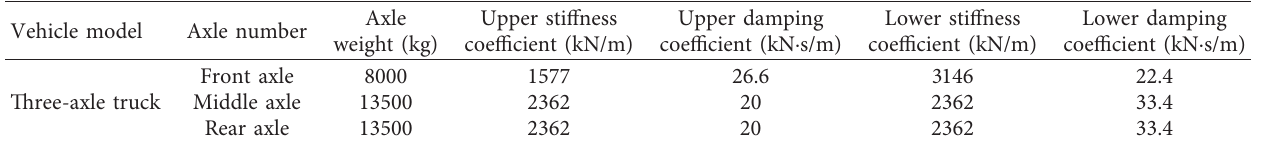
Figure 9: Information of bridge model and dynamic test (unit: Table 3: Technical parameters of the vehicle [31].